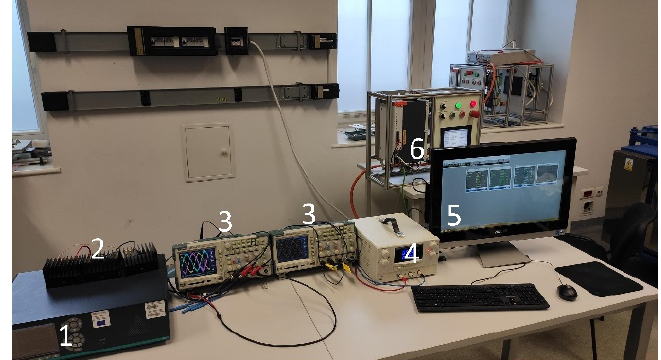
Figure 10. Measuring equipment.